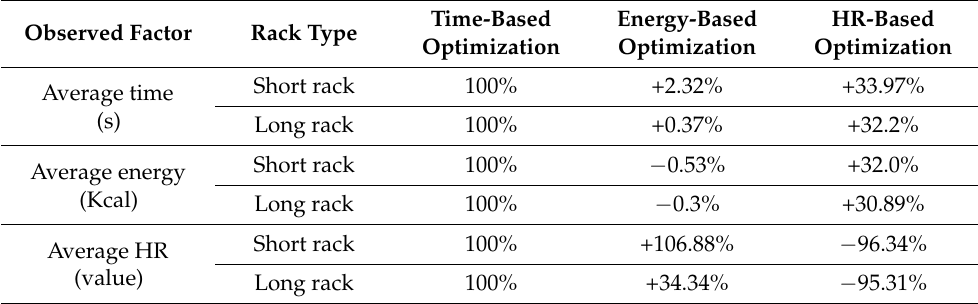
Table 7. Comparisons of the average results from the perspective of time-based optimization.